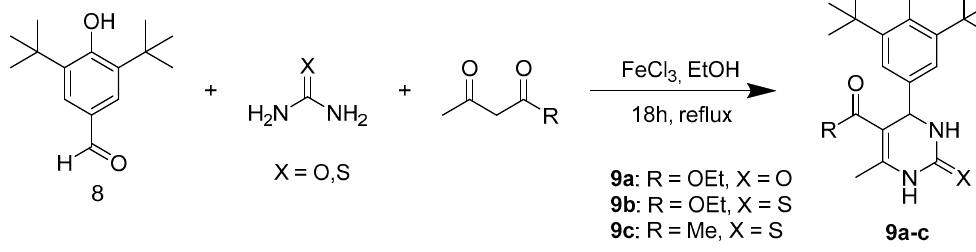
Figure 2 . NMR 1 H- 13 C HMBC spectra of 7